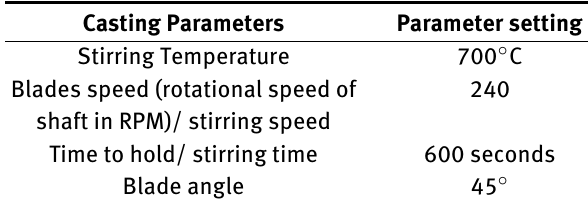
Table 5: Stir casting parameters for the development of composite Casting Parameters